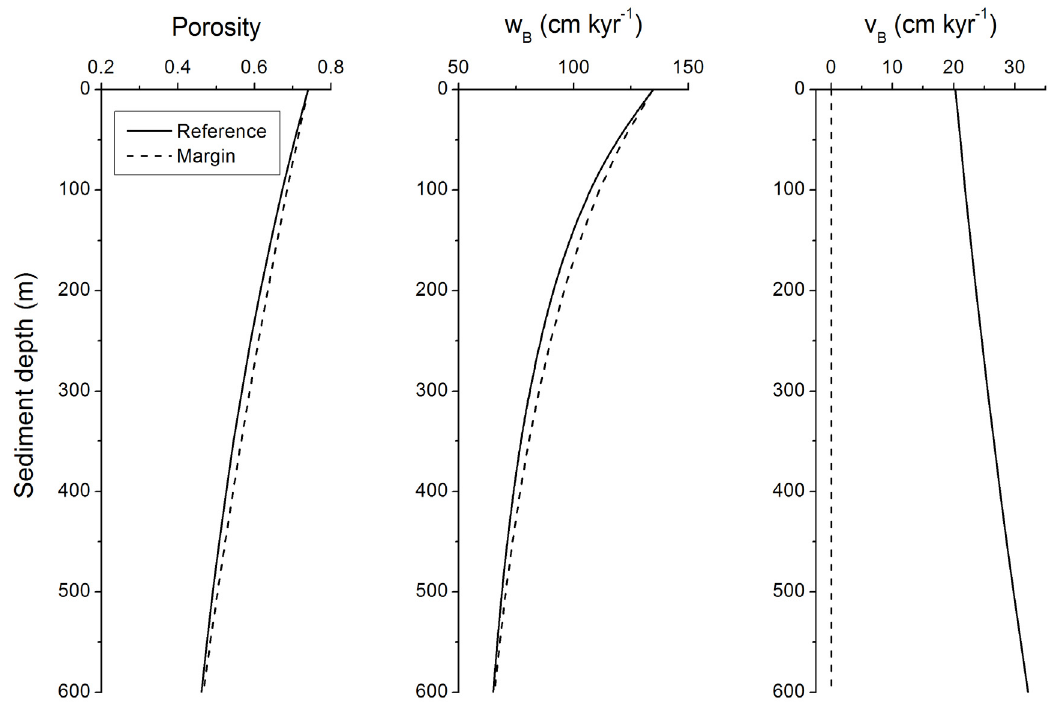
) and pore waters ( v ) applied in the B B = 0.74, Φ = 0.3, p = 1/600 m − 1 0 f